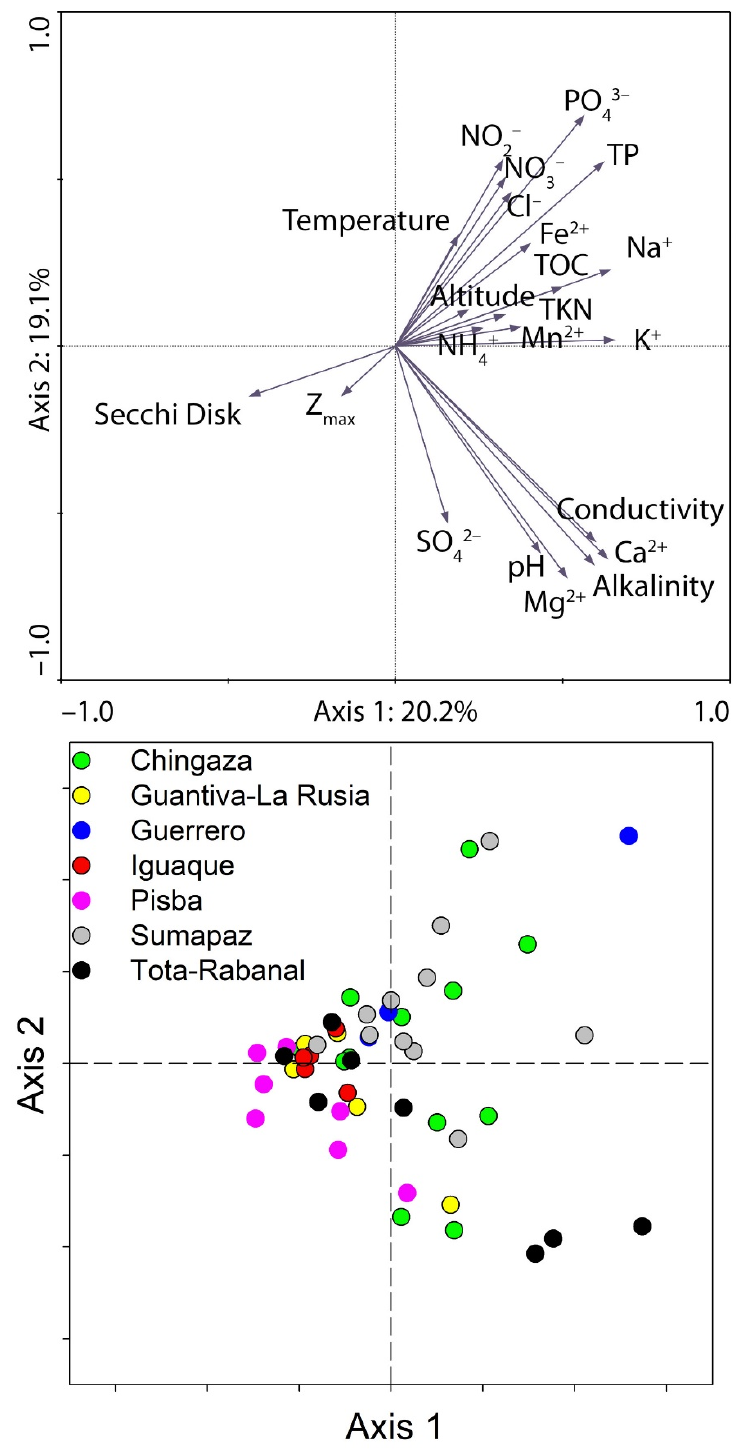
Figure 5. Biplot of the principal component analyses of selected environmental variables. The upper figure presents the relationship between the environmental variables. The direction of the arrows indicates the direction of the gradient and the position of samples with the highest values of each variable. The closer the arrows, the more correlated are the environmental variables. The second figure shows the position of each lake with respect to the environmental variables. The colors of the lakes correspond to the different páramo complexes studied.